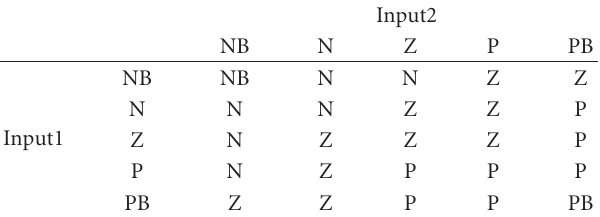
Table 1: Rule base for the fuzzy Kalman